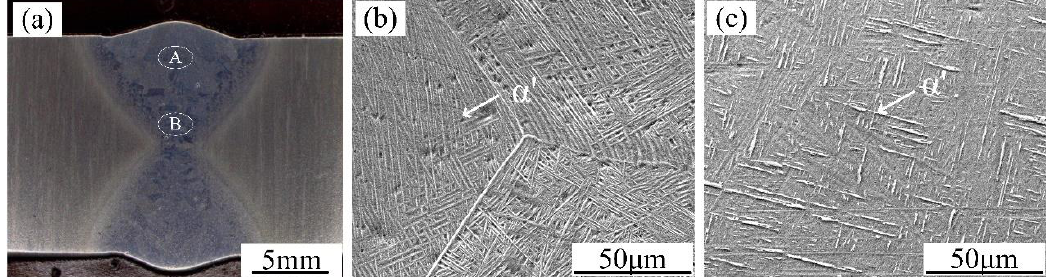
Figure 5. Microstructure of the laser-MIG joint ( E = 3.4 × 10 3 J/cm): ( a ) Cross-section profile of weld joints; ( b ) Cosmetic weld zone; and ( c ) Backing weld zone.